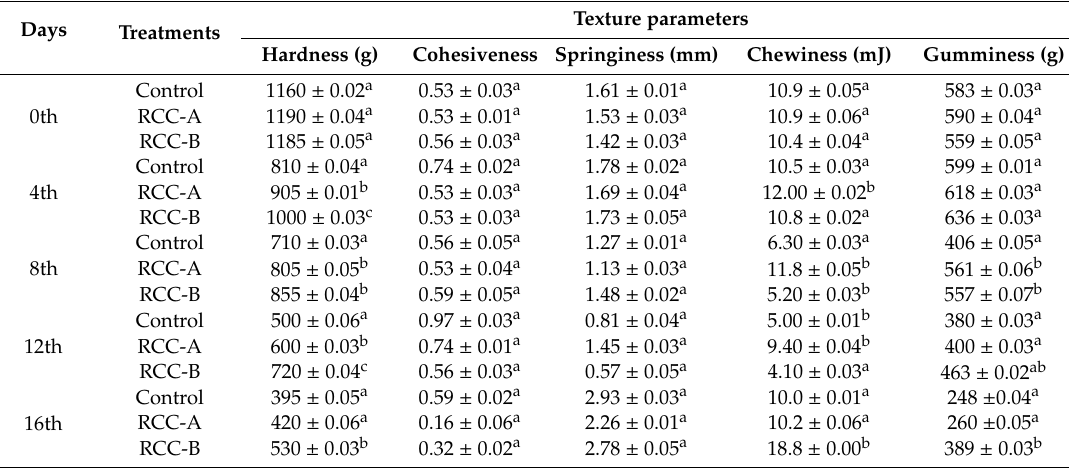
Table 7. Texture profile analysis of RC extract on muscle of beef meat during storage at 4 ◦ C. All the values are mean ± SD; letters a — c are given according to the increasing mean values; values for each parameter sharing same letter in each column represents non significance di ff erence at p > 0.05; values for each parameter sharing di ff erent letter in each column represents significance di ff erence at p <